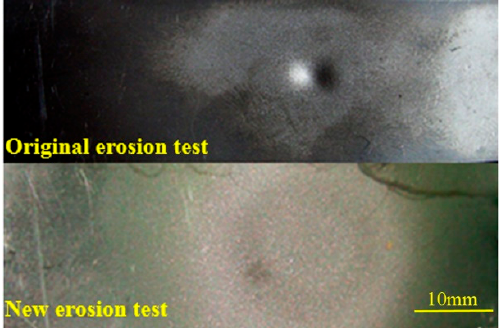
Figure 3. Comparison of the erosion scars on the target surface before and after the redesigning of the test sections.